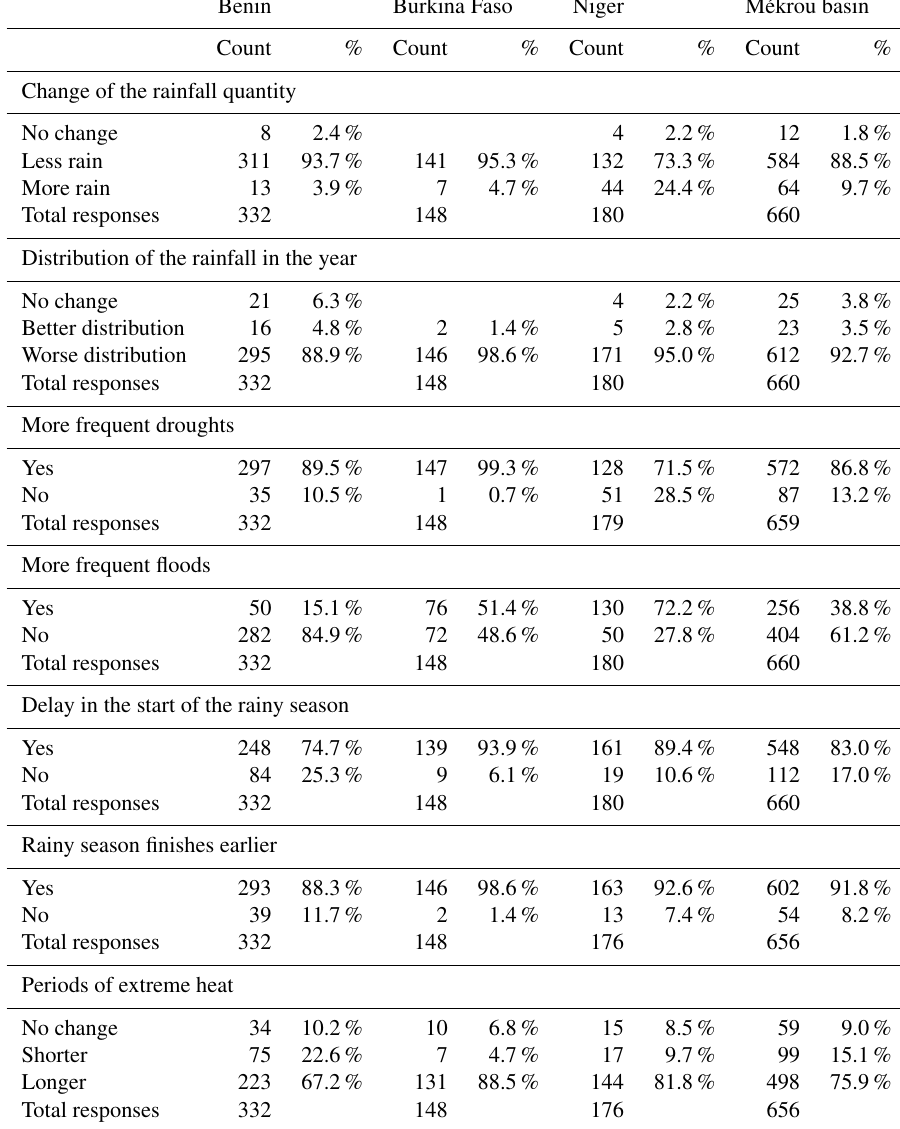
Table 4. Observed climatic changes during the last 10 years of the study period: 2006–2015.